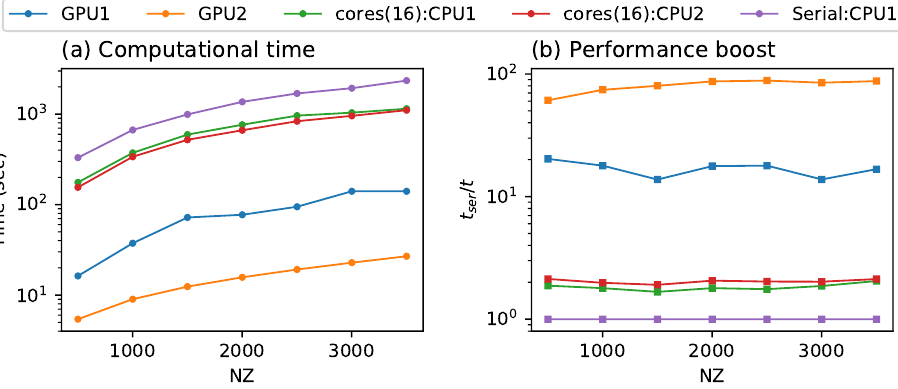
Figure 22. Comparison of computational for 20 iterations time and performance for variation of spatial grid size along Z direction NZ keeping spatial grid size along X direction and temporal grid constant ( NX = 201, NT = 1000) in FWI